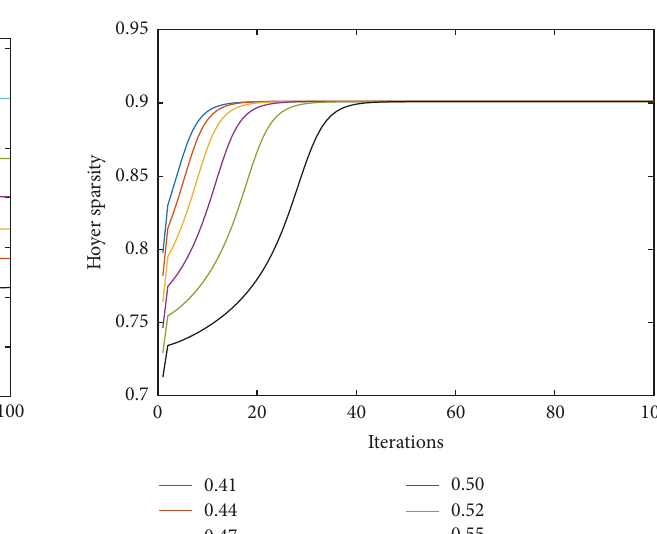
Figure 4: The Hoyer sparsity.